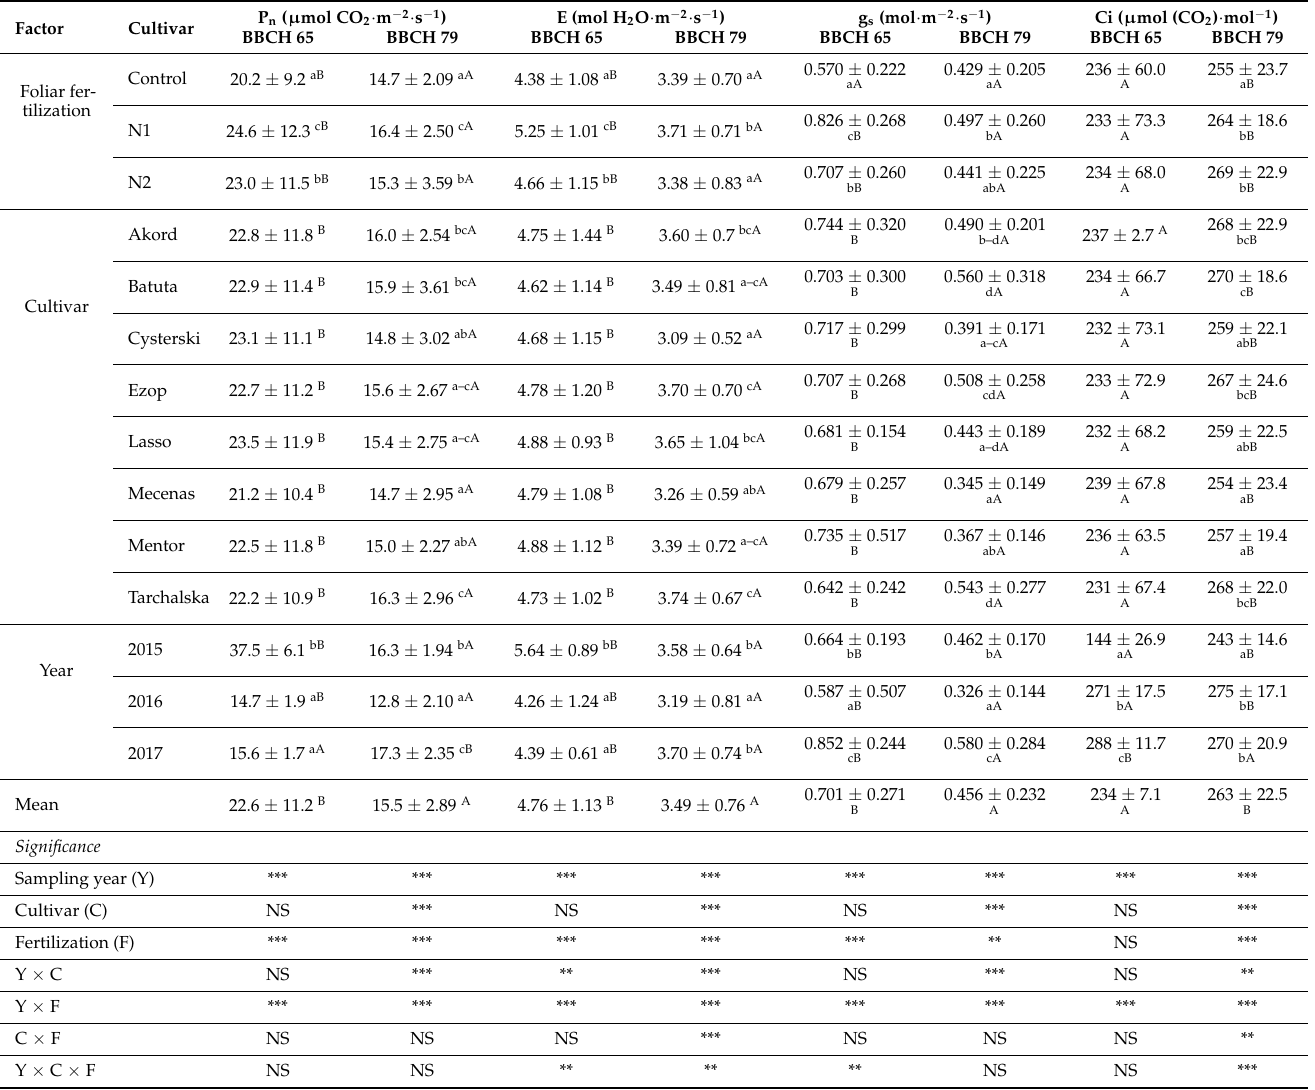
Table 3. The intensity of photosynthesis net (P n ), transpiration rate (E), stomatal conductance (g s ), and intercellular CO 2 concentration (Ci) in pea bracts at two growth stages (BBCH 65 and BBCH 97) according to fertilization (F; Control, N1, N2), cultivar (C; eight cultivars) and years of study (Y;